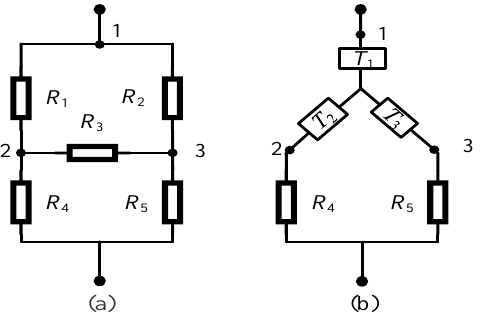
Figure 3. ( a ). bridge network consists of five resistance elements. ( b ). Equivalent network of the bridge network.